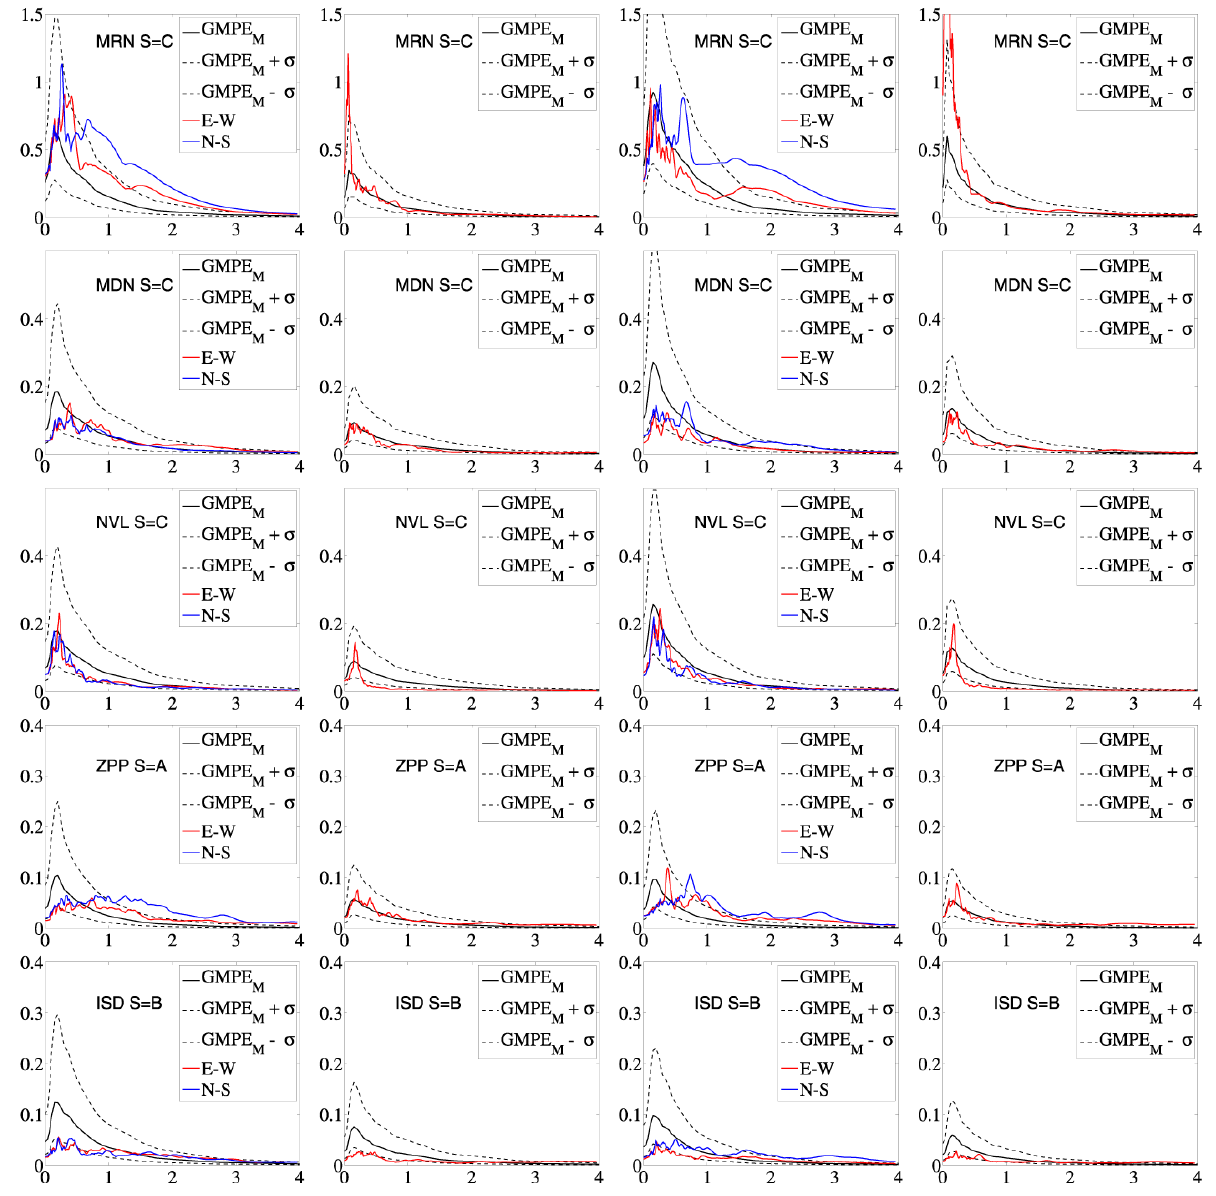
Figure 5. Comparison between GMPE-predicted and actual spectra for the May 20 (first and second columns from the left) and the May 29 (third and fourth columns from the left), 2012, events. First and third columns refer to horizontal components, while second and fourth column refer to vertical compo- nents. Vertical axis: always S (g); Horizontal axis: always T (s). a